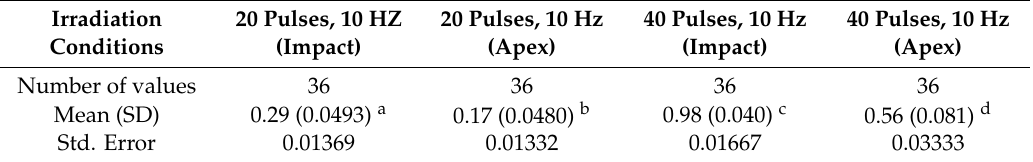
Table 6. Means and standard deviations are shown for each irradiation condition. SD: Standard deviation. Lowercase superscript letters (a, b, c and d) indicate statistically significant di ff erences (Newman–Keuls; p < 0.0001) between